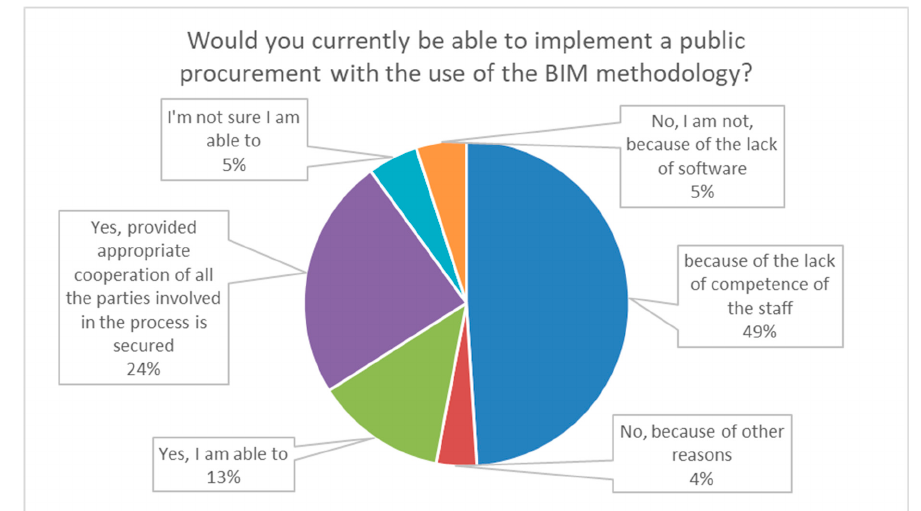
Figure 3. Survey on the implementation of BIM [19].